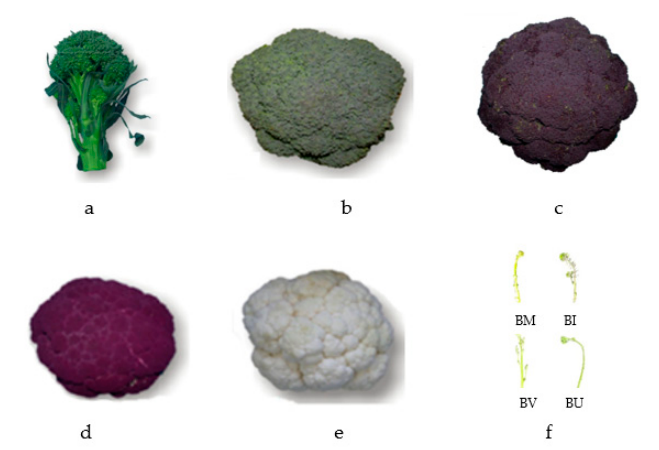
Figure 3. Inflorescence induction in relation of the different morphotypes tested which are, in the following order, ( a ): BR5, ( b ): BRF1.1, ( c ): BR41, ( d ): CV10, ( e ): CVF1.1, ( f ): BM1, BI1, BV and BU1, respectively. Table 6. List of B. oleracea complex species ( n = 9) utilized in the experiment, with cauliflowers and broccoli F1 and landraces, respectively, and crop wild relatives.